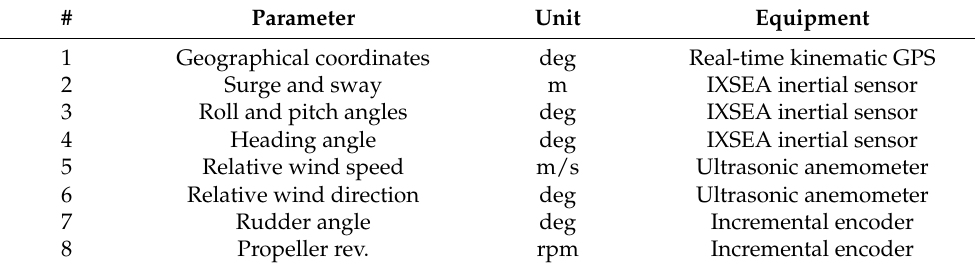
Table 2. Measured